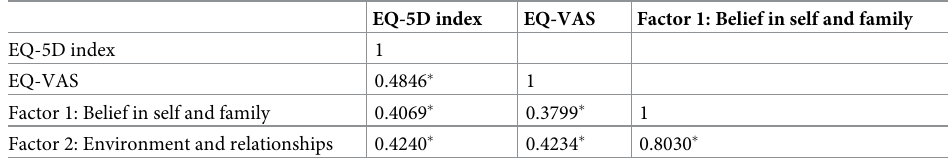
Table 5. Correlation matrix with EQ-5D index and EQ-VAS to assess concurrent validity.